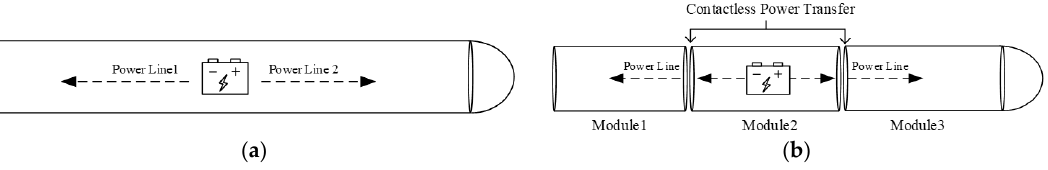
Figure 1. Architectures of the power supply for long electric systems. ( a ) Traditional solution. ( b ) Contactless solution for the modular design.